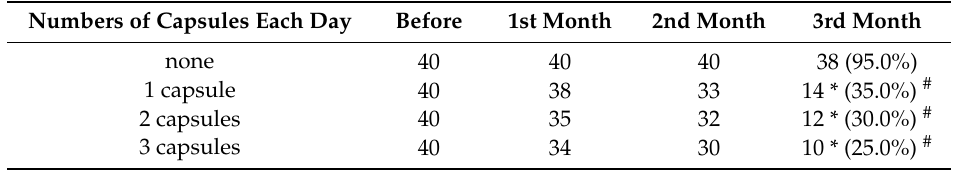
Table 2. Change in ocular floaters before and after the fruit enzymes at di ff erential concentration over a 3-month